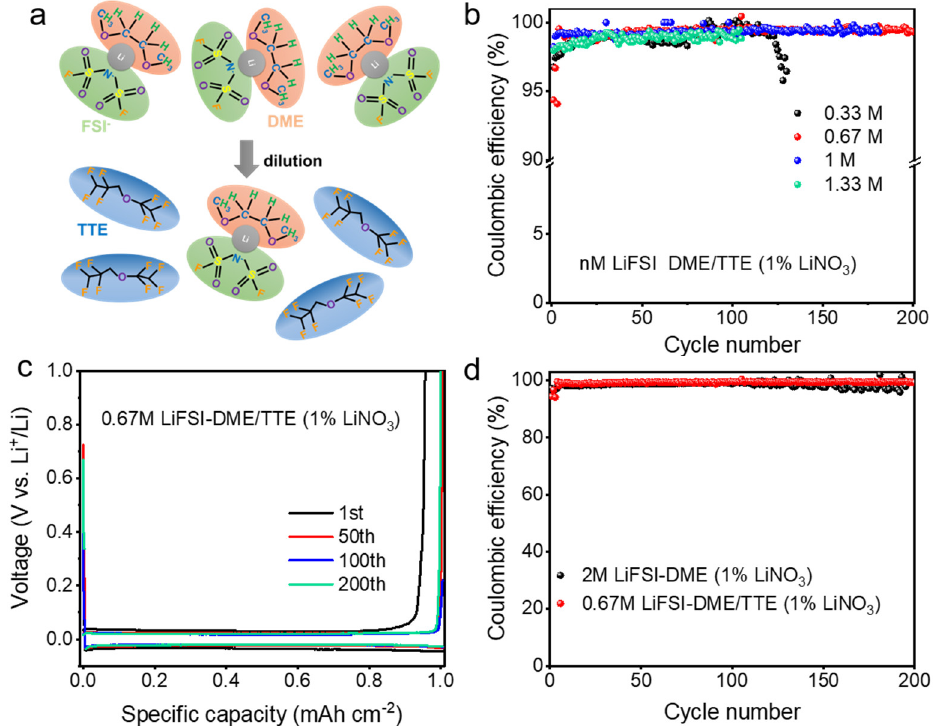
Figure 1. ( a ) Schematic illustration of the solvate structures of high–concentration electrolyte (top) and diluted electrolyte (bottom), with LiFSI, DME, and TTE as salt, solvent, and diluent, respectively; ( b ) CE test of Li||Cu half–cells electrolytes with different lithium salt concentration (0.5 mA cm -2 , 1 mAh cm -2 ); ( c ) The galvanostatic charge–discharge curves of 0.67 M LiFSI in DME/TTE (1% LiNO 3 ); ( d ) CE test of Li||Cu half–cells with different ratios of diluents.